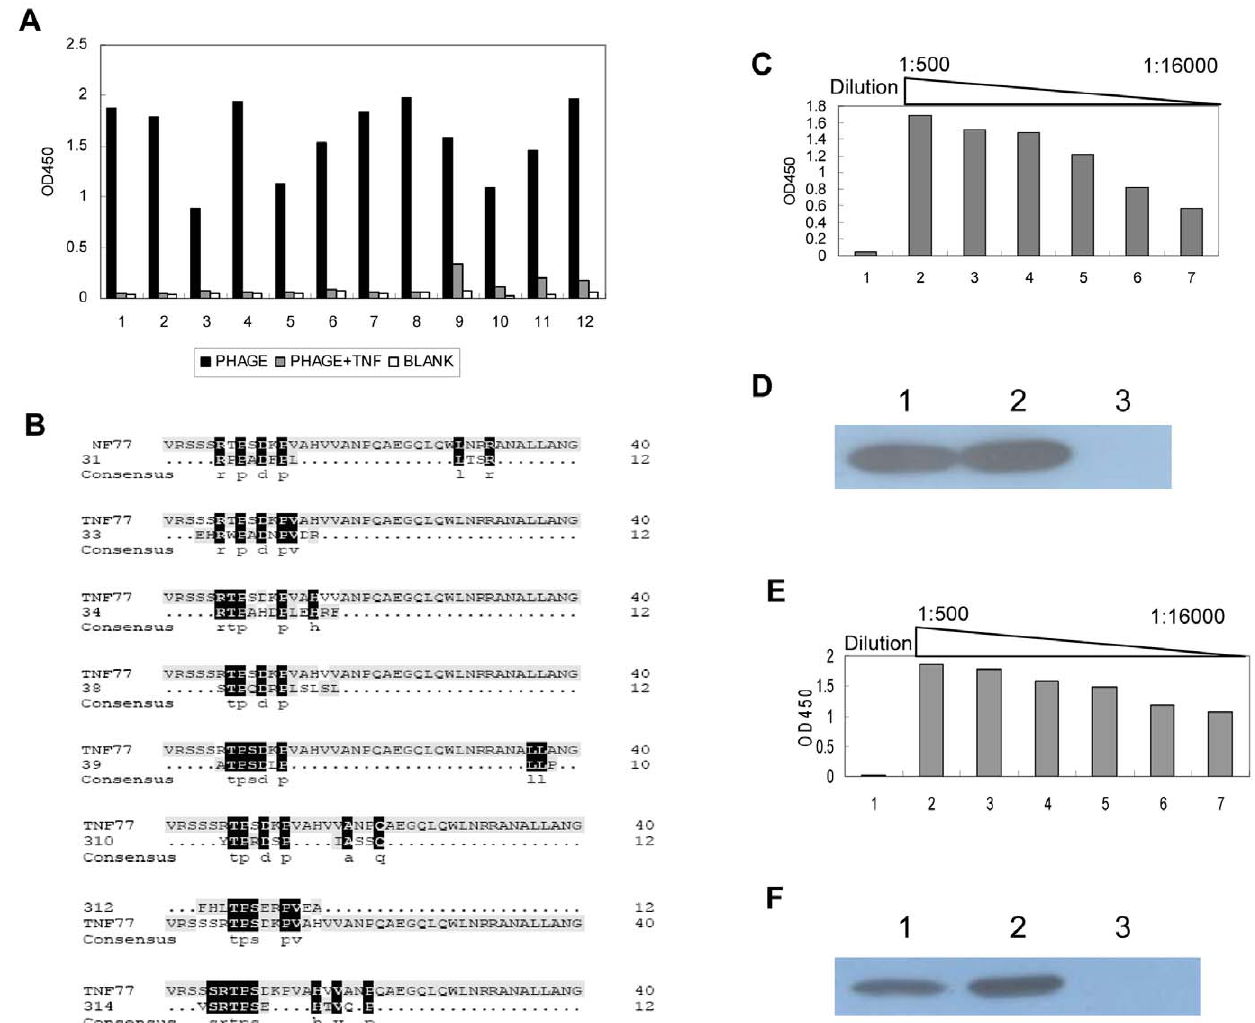
Figure 1. Identification of the mimotope and epitope of hTNF- a . A: Specific phage clones binding to rhTNF- a antibodies were selected by ELISA and competitive ELISA. 1–12 referred to different phage clones. White bars represent negative control, black bars represent screened phage clones (1 6 10 9 ) alone, and gray bars represent screened phage clones (1 6 10 9 ) plus rhTNF- a protein (5 m g). B: Sequence similarity between binding peptides and rhTNF- a . 31, 33, 34, 38, 39, 310, 312 and 314 represent different binding peptides. All the selected binding peptides were homologous to the region 80–91aa of rhTNF- a . C: Development of anti-rhTNF- a antibodies using KLH-312.The interaction between rhTNF- a and sera was tested by ELISA. Results are expressed as OD at 450 nm. Group1: the control group sera immunized with KLH diluted as 1:500; group2–7: sera